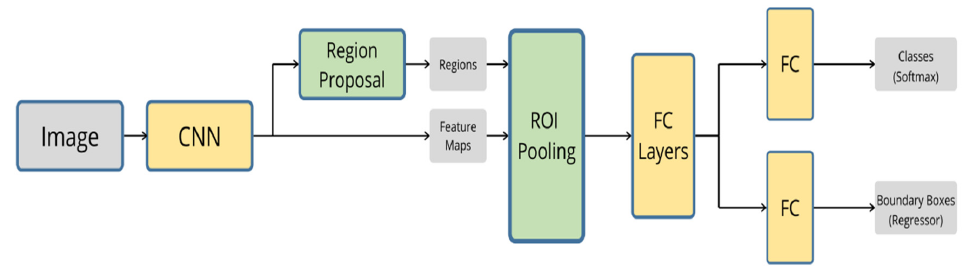
Figure 13. The architecture of faster R-CNN.